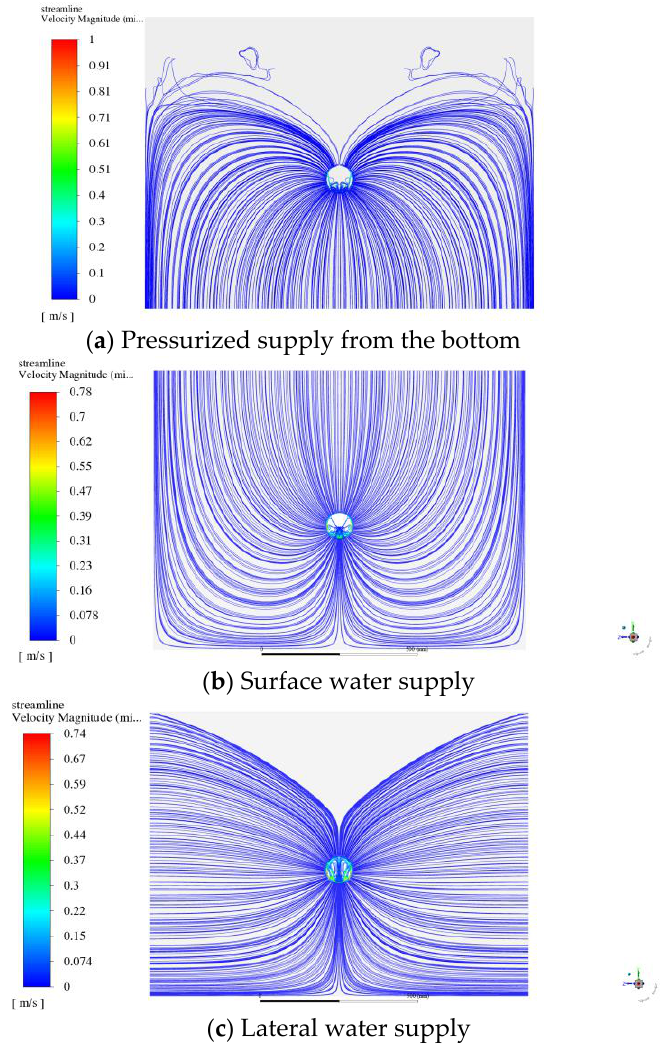
Figure 11. Streamlines with the velocity magnitude (m/s) for the global – local flow field.